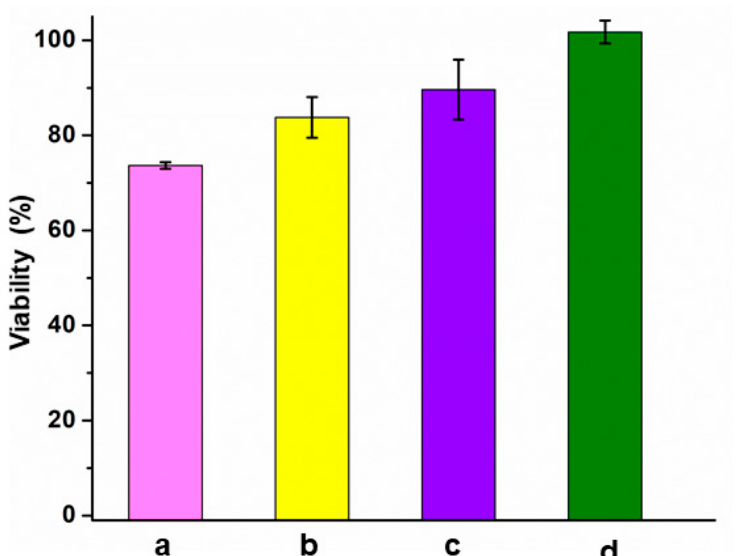
Figure 7. Cell viability of the leachates collected from a—OB, b—OB-POX, c—OB-POX/L-Trp, d—OB-POX/D-Trp incubated in phosphate-buffered saline at pH 7.2 for seven days.